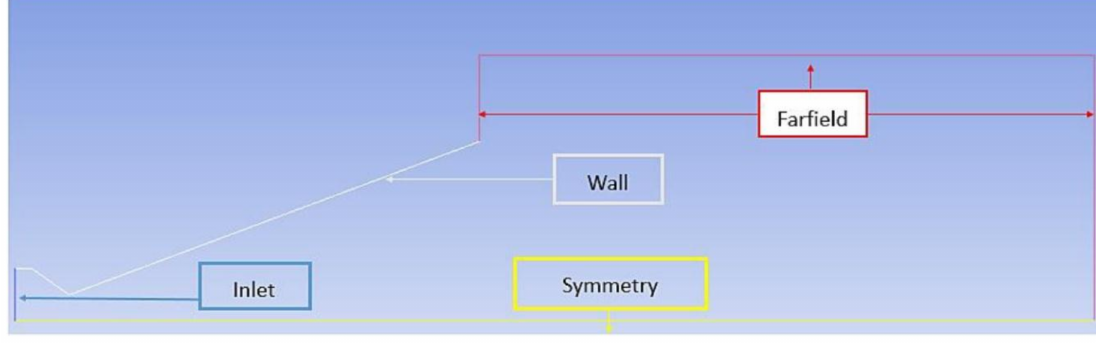
Figure 11. Dual bell nozzle geometry.